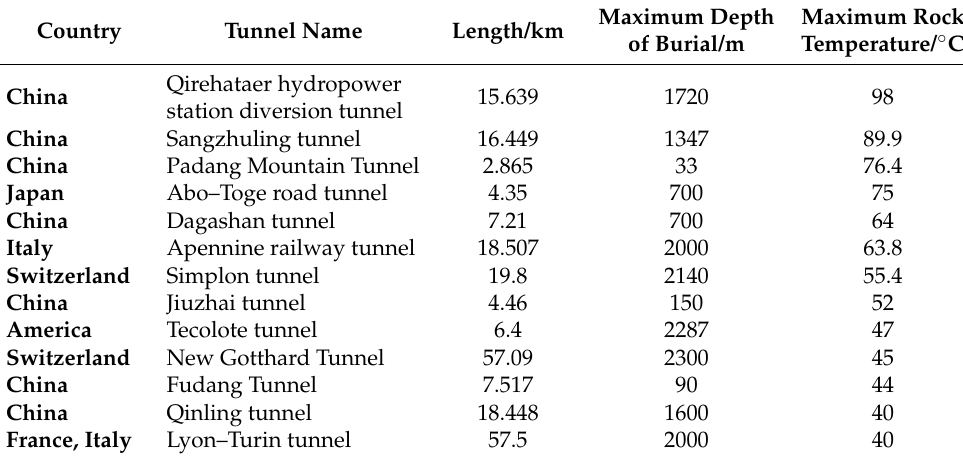
Table 1. High geothermal tunnel cases